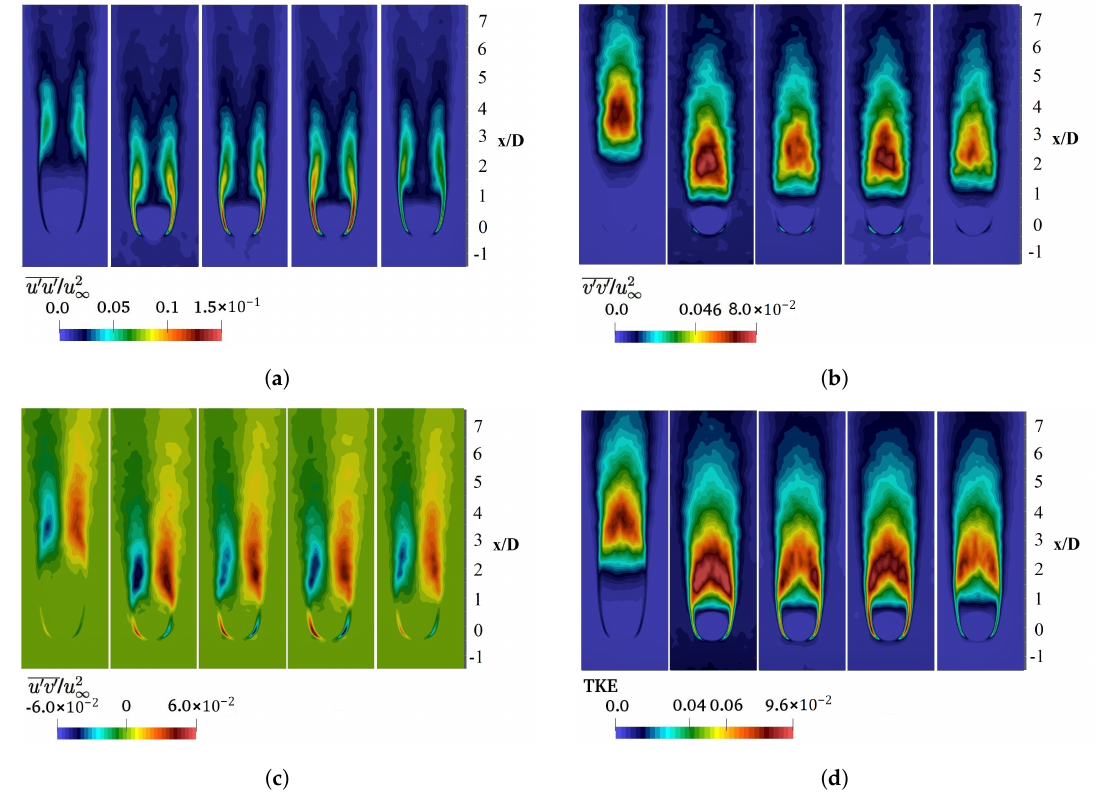
Figure 18. Comparison of the Reynolds stresses and turbulent kinetic energy of the 3 mm water drops falling in stagnant and turbulent surroundings: ( a ) u (cid:48) u (cid:48) / u 2 ∞ . ( b ) v (cid:48) v (cid:48) / u 2 ∞ . ( c ) u (cid:48) v (cid:48) / u 2 ∞ . ( d ) Turbulent kinetic energy. From left to right: cases D3T0, D3L050T10, D3L025T10, D3L050T05,